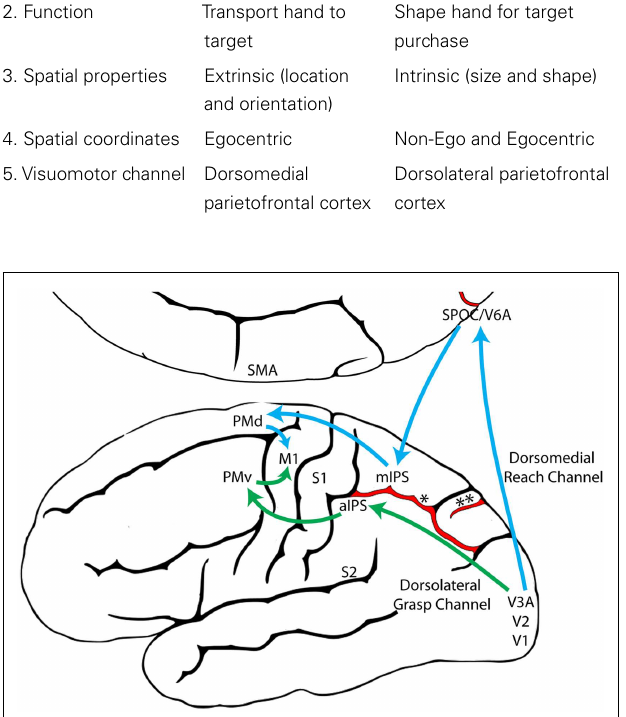
FIGURE 1 |The dorsomedial Reach pathway (Blue) and the dorsolateral Grasp pathway (Green), adapted from Grafton (31) . (aIPS, anterior intraparietal sulcus; M1, primary motor cortex; mIPS, medial intraparietal sulcus; PMd, dorsal premotor cortex; PMv, ventral premotor cortex; S1, primary somatosensory cortex; S2, secondary somatosensory cortex; SMA, supplementary motor area; SPOC, superior parieto-occipital cortex; V1, primary visual cortex;V2, secondary visual cortex;V3A, visual area 3A; V6A, visual area 6A; *, intraparietal sulcus; **, parieto-occipital